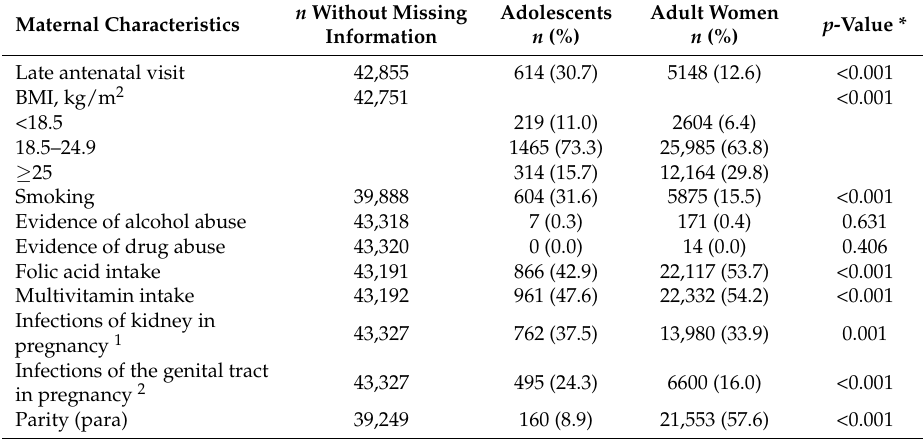
Table 1. Bivariate analyses of maternal medical and behavior characteristics, according to mothers’ age, the ACBR, Russia, 2012–2014.